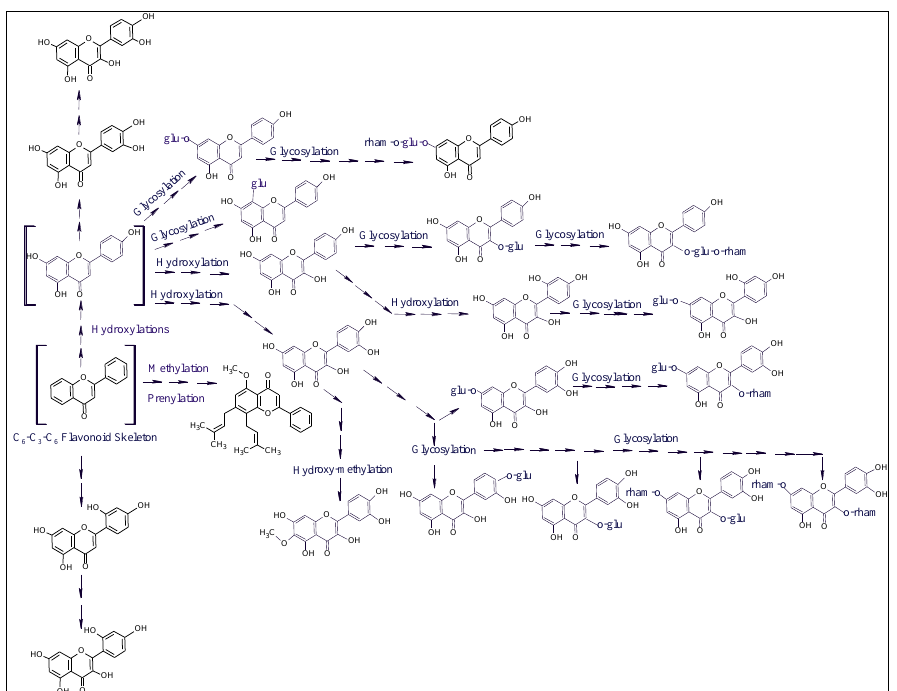
Figure 6. The proposed plausible biogenetic interrelationship and molecular oxygen proliferation in flavonoids from different plants. The products shown in parenthesis have not been detected in the current study.